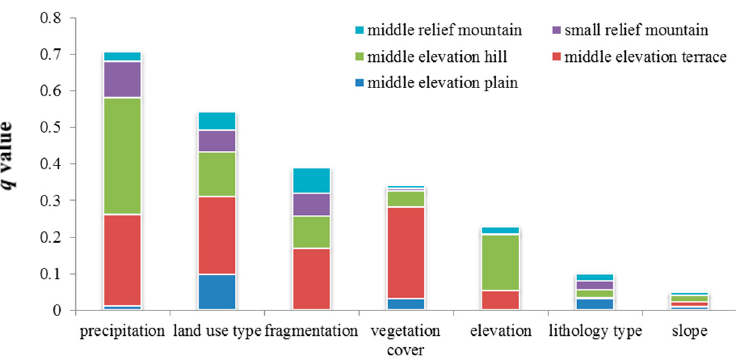
Figure 3. The q values of the factors influencing the surface runoff in the different geomorphic regions.